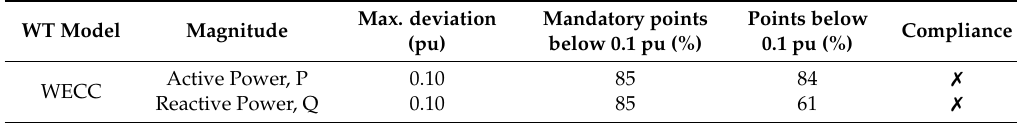
Table 3. Verification of the PVVC validation criteria applied to the WECC WT model at the testing point, operating at partial load conditions: 20 kV, measurement point at HV side.